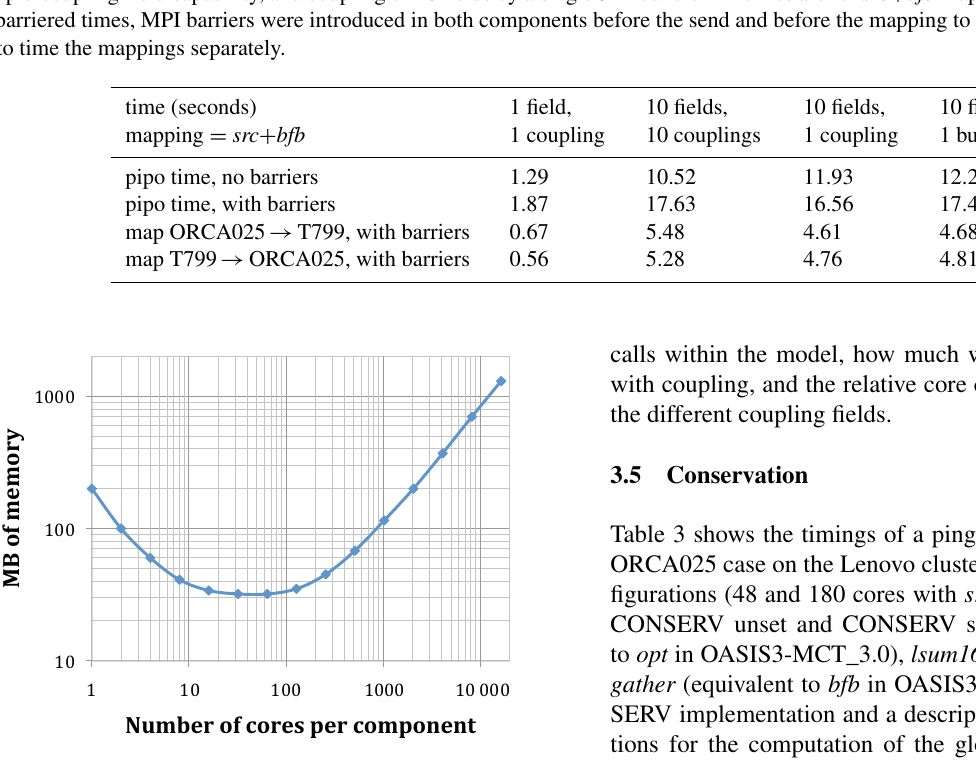
Figure 5. OASIS3-MCT_3.0 memory use on Curie Bullx for the T799-ORCA025 toy model as a function of cores per